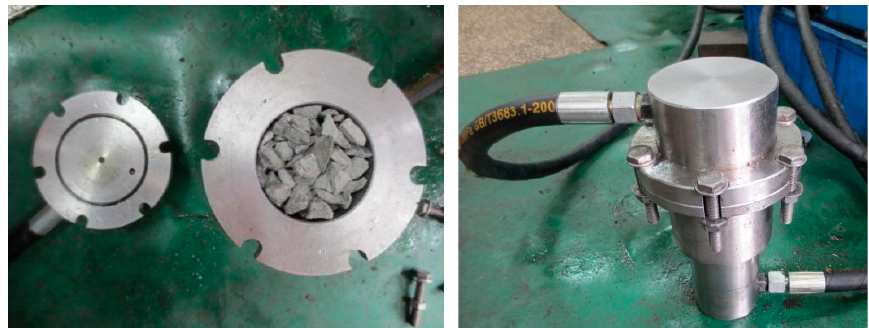
Figure 3. Filling method of the sample in the osmosis device.